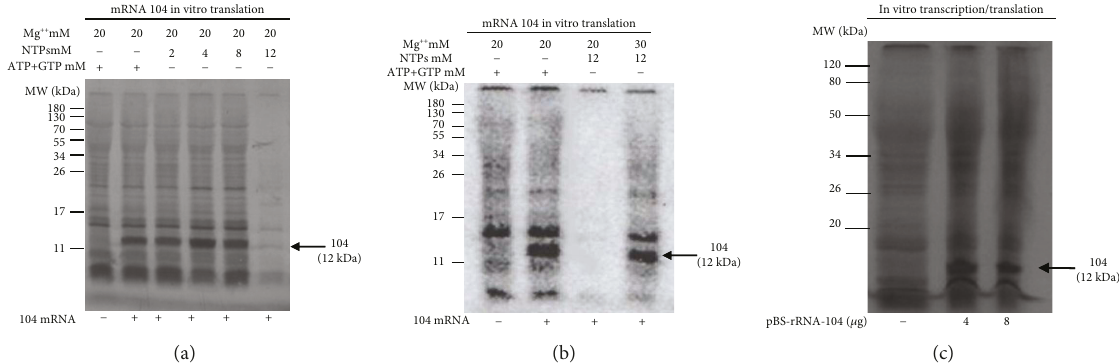
Figure 3: In vitro expression of ORF 104 under di ff erent experimental conditions. 4 μ g of in vitro-transcribed 104 mRNA were translated at di ff erent concentrations of NTPs (a) and Mg 2+ (b) for 1 h in 25 μ l of reaction. (c) Di ff erent amounts of pBS-rRNA incubated with S. solfataricus whole cell extract for 60min at 70 ° C in a fi nal volume of 25 μ